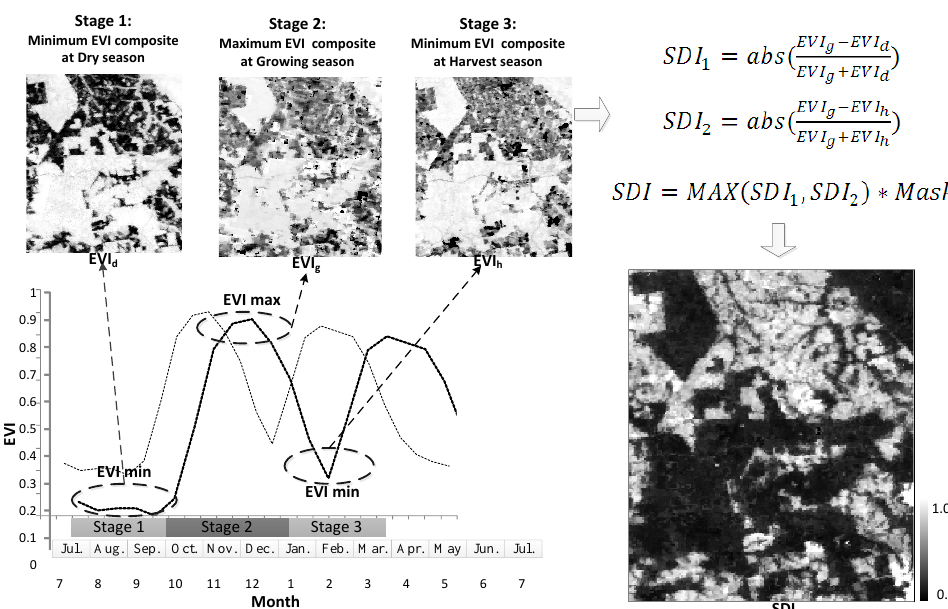
Figure 4. The Enhanced Vegetation Index (EVI) features at different crop growth stages and the seasonal dynamic index.